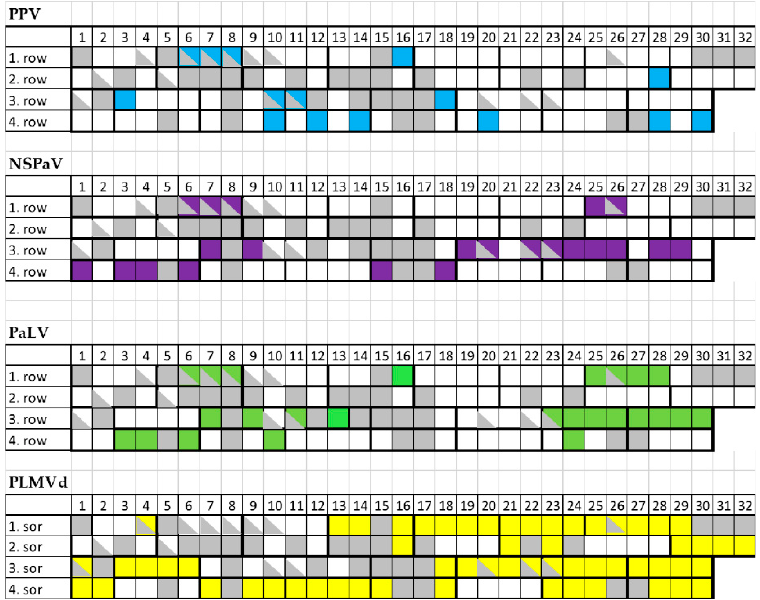
Figure 9. A summary of the virus diagnostic surveys investigating all the individual trees in the peach isolator house. Virus-infected trees are shown by different colors: PPV: blue; NSPaV: violet; PaLV: green; PLMVd: yellow.